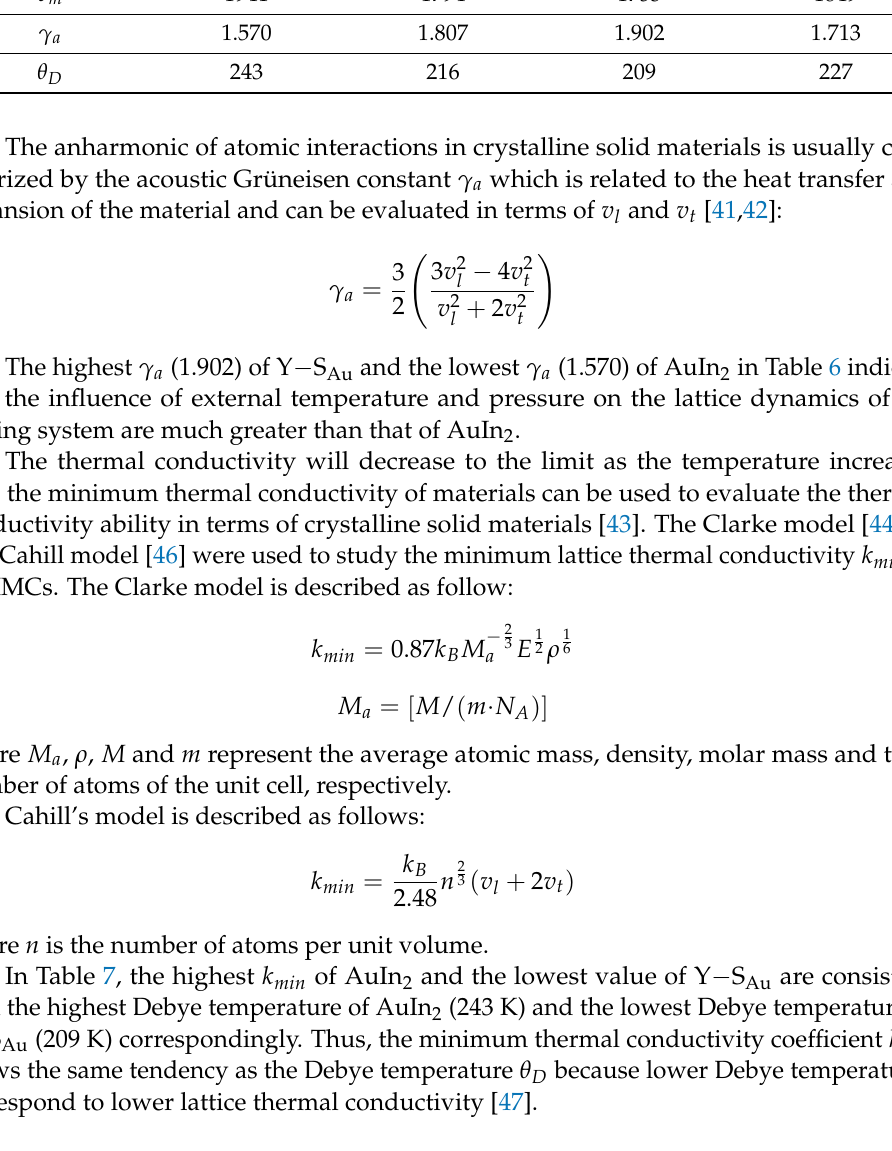
Table 6. The density ρ (g/cm 3 ), sound velocity (longitudinal v l (m/s), transverse v t (m/s) and mean v m (m/s), acoustic Grüneisen constant γ a and Debye temperature θ D (K) of AuIn 2 and doping system. Phase AuIn 2 Sc − S Au Y − S Au Y − S In ρ 6.196 6.127 6.147 6.185 v l 4776 4541 4510 4624 v t 2704 2403 2321 2515 v m 1941 1794 1753 1849 γ a 1.570 1.807 1.902 1.713 θ D 243 216 209